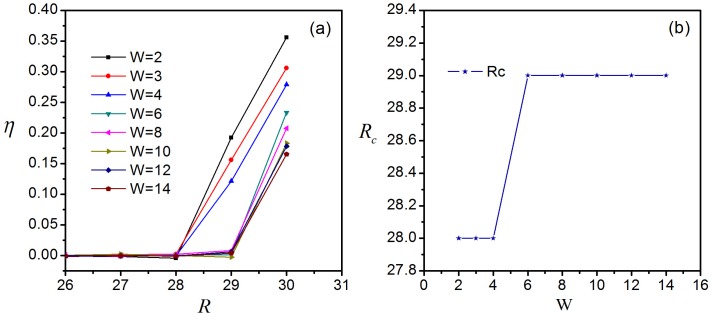
Influence of W in NDA algorithm.(a) Variance of η with increasing R; (b) variance of Rc with increasing W.